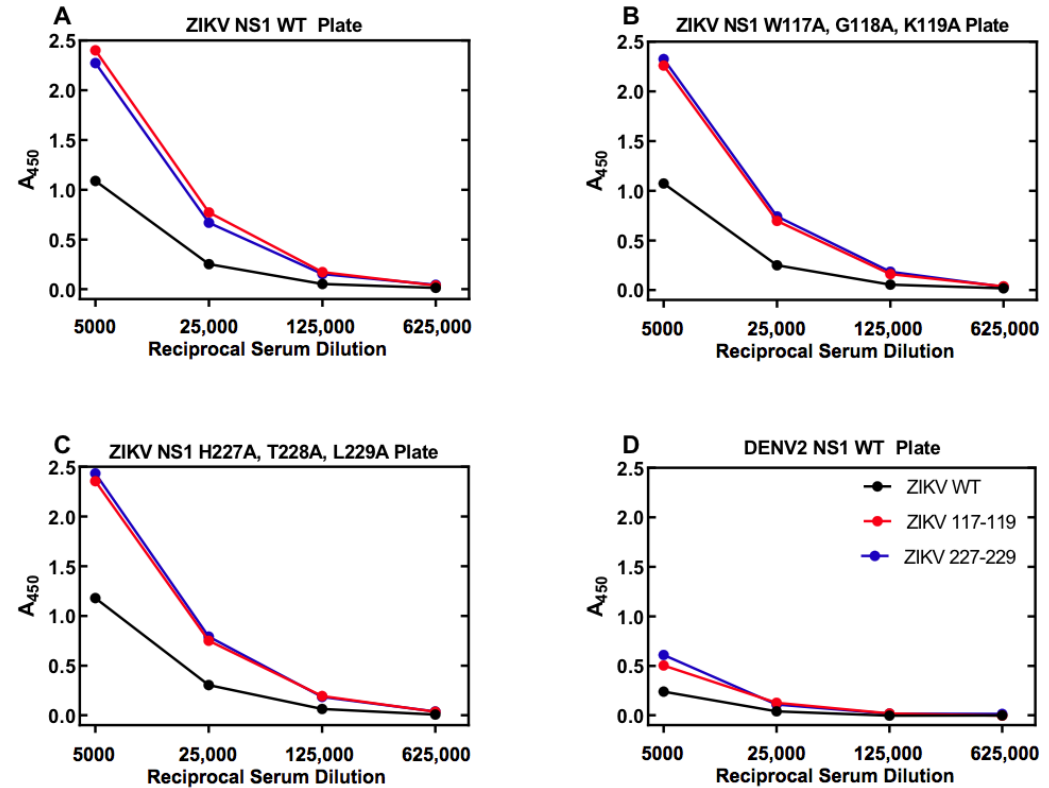
Figure 4. Serum from goats immunized with ZIKV mutants show differential binding to NS1 proteins. Antibody-capture ELISA was performed on a mixture of serum from two goats immunized with ZIKV NS1 protein. Binding of WT ZIKV NS1 showed lower binding to WT ( A ), both mutants ( B , C ), as well as DENV2 WT NS1 ( D ). Data represent samples run in duplicate. Error bars (standard error of the mean) were smaller than the symbols as drawn. The experiment was repeated a total of three times. The legend in panel ( D ) also applies to panels ( A – C ).